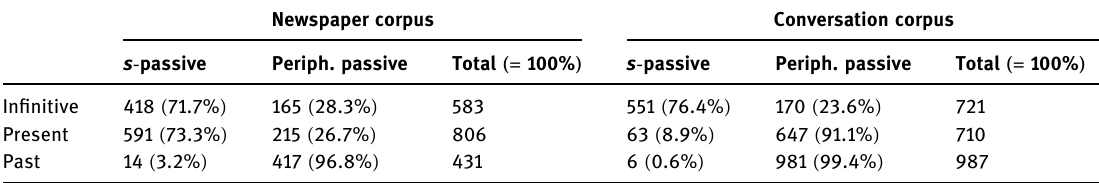
Newspaper corpus Conversation